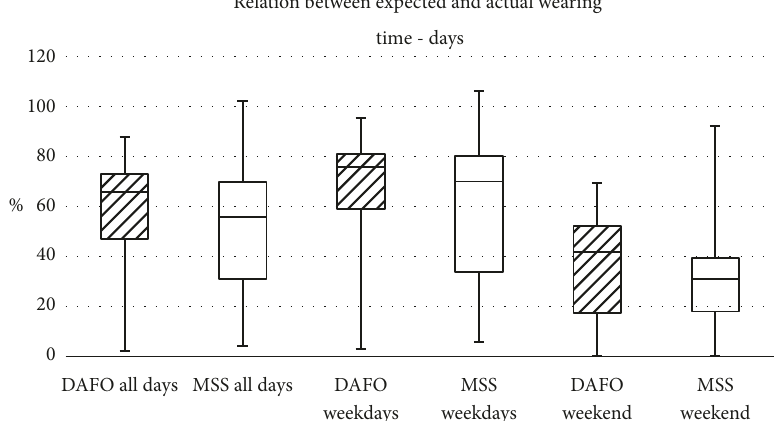
Figure 3: Relation between expected and actual wearing time with focus on the days worn.